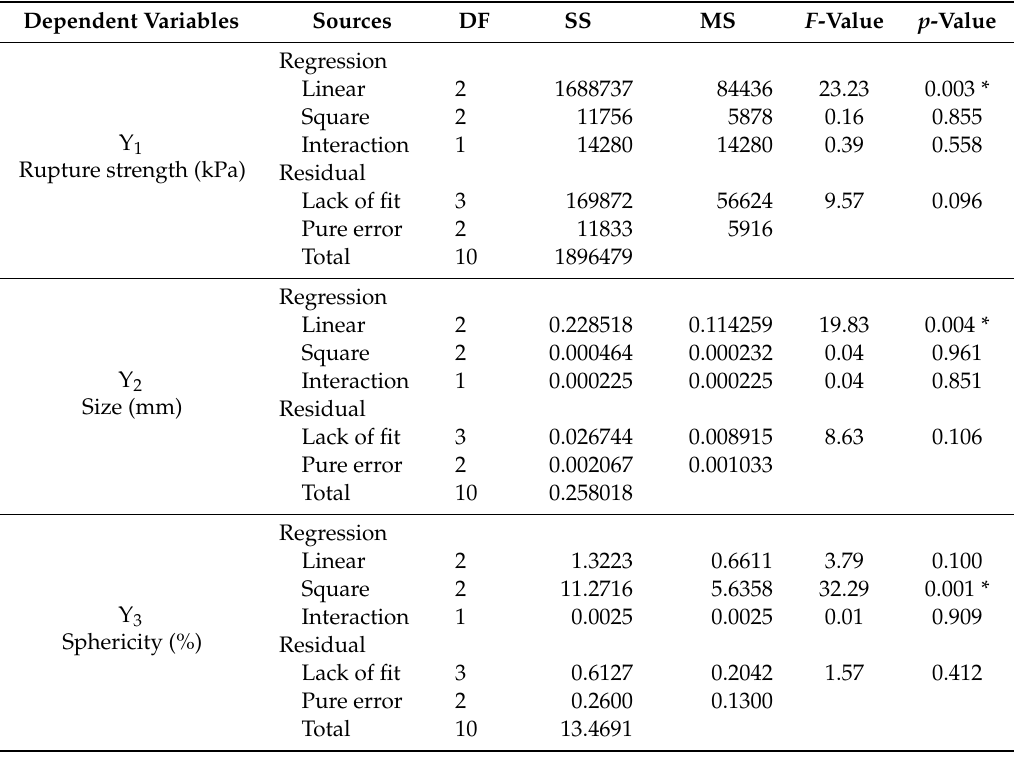
Table 4. Analysis of variance for dependent variables.